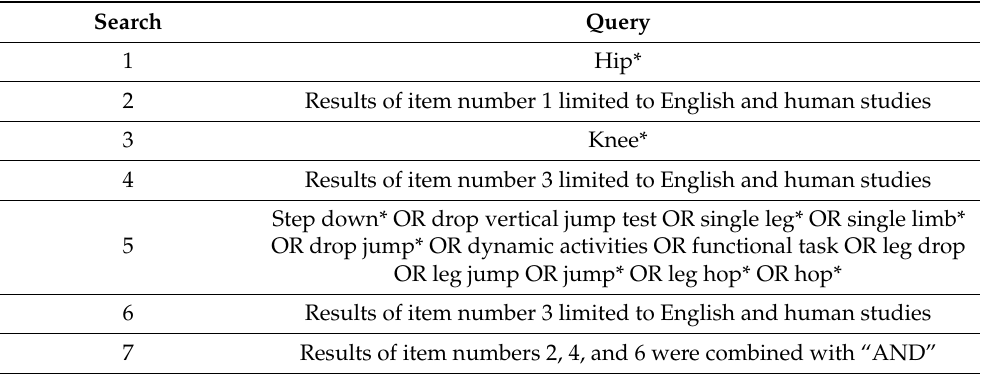
Table 1. Search strategy for the MEDLINE